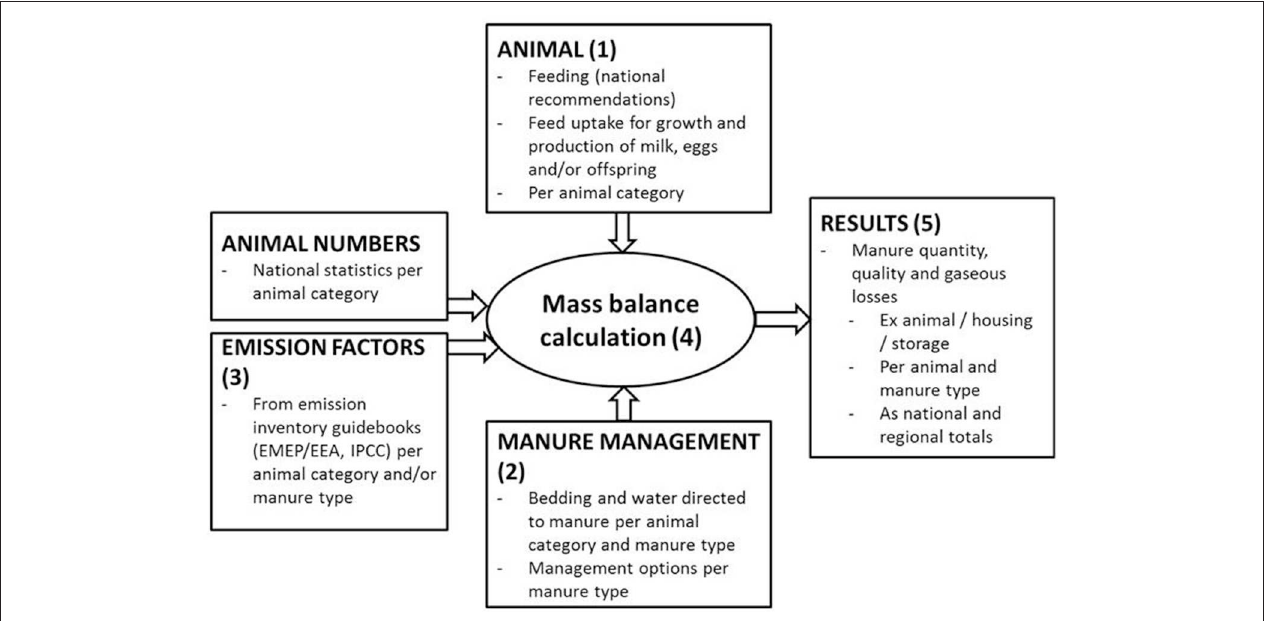
FIGURE 1 | The structure of the Finnish Normative Manure System.